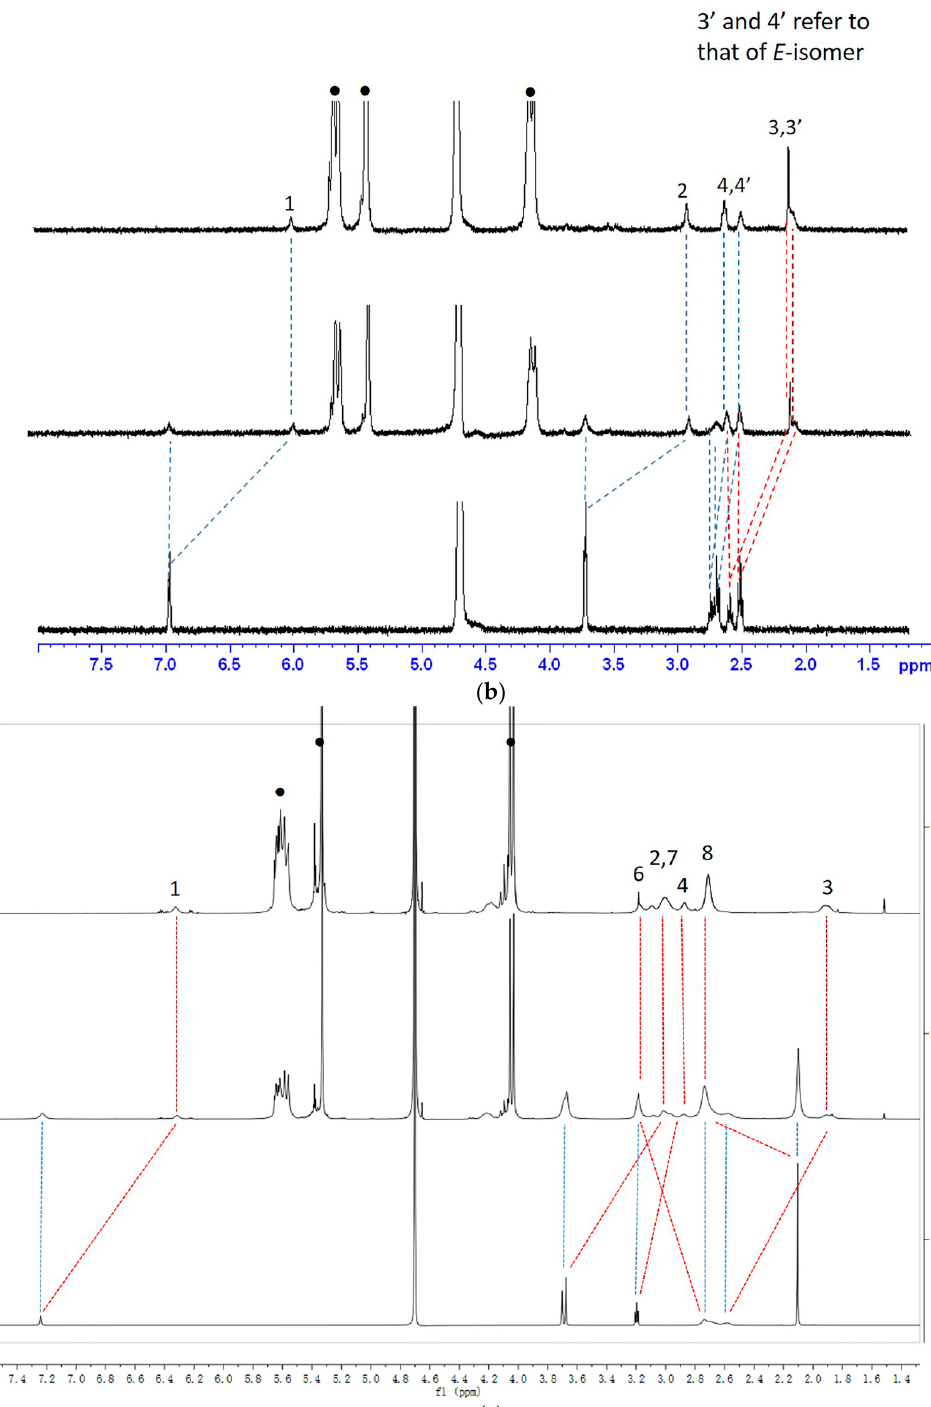
Figure 2. 1 H-NMR (400 MHz) spectra of ( a ) cimetidine; ( b ) famotidine and ( c ) nizatidine, in the